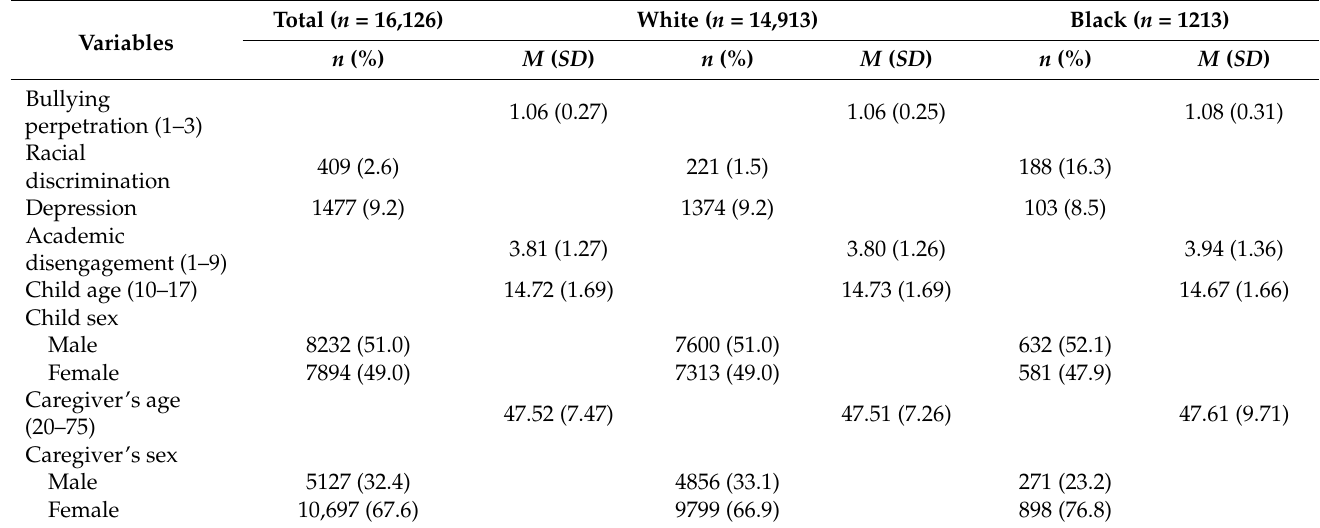
Table 1. Descriptive Statistics of the Total